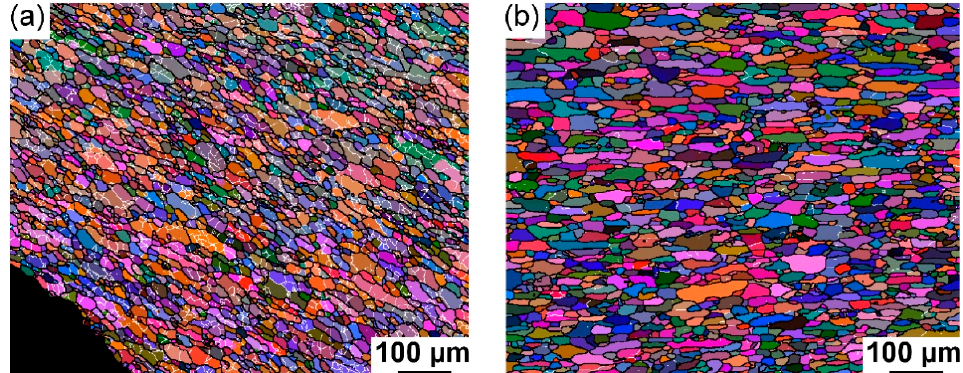
Figure 6. Microstructure in different regions on the AA6061 side of the friction stir welded AA6061/MMC plate analyzed using the EBSD technique: ( a ) stir zone (region B in Figure 3b) where EBSD pattern indexing was possible only for the AA6061 alloy and where the black corner corresponds to the MMC; ( b ) HAZ (region C in Figure 3b). LABs and HABs are shown as white and black lines, respectively. Table 1. Parameters of the microstructure determined using EBSD in the AA6061 alloy. Zone d (µm) Aspect ratio Fraction of LABs (%) Stir zone